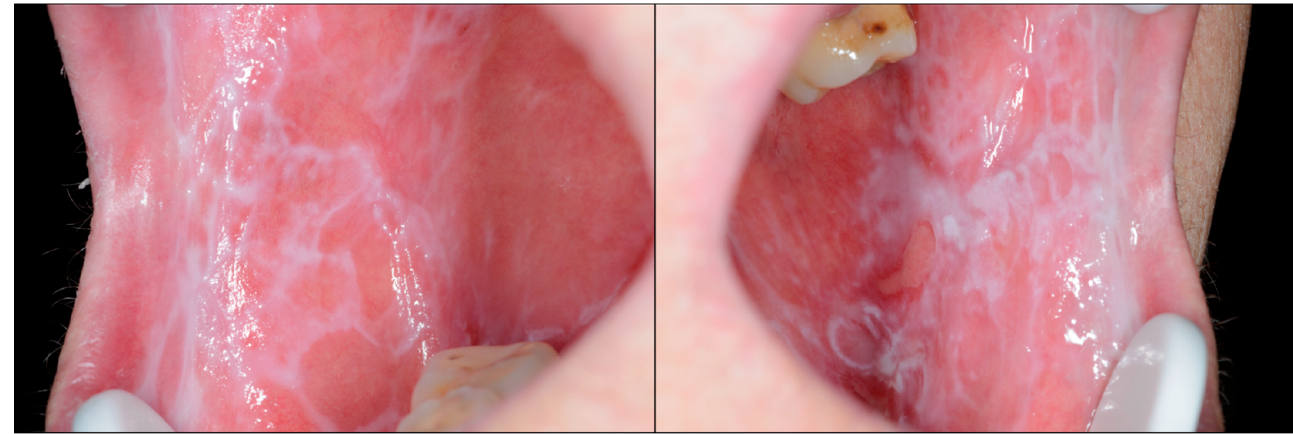
Figure 1. Patient presenting bilateral reticular lesions typical of oral lichen planus; in addition, some erosive lesions appear in the left buccal mucosa [4].